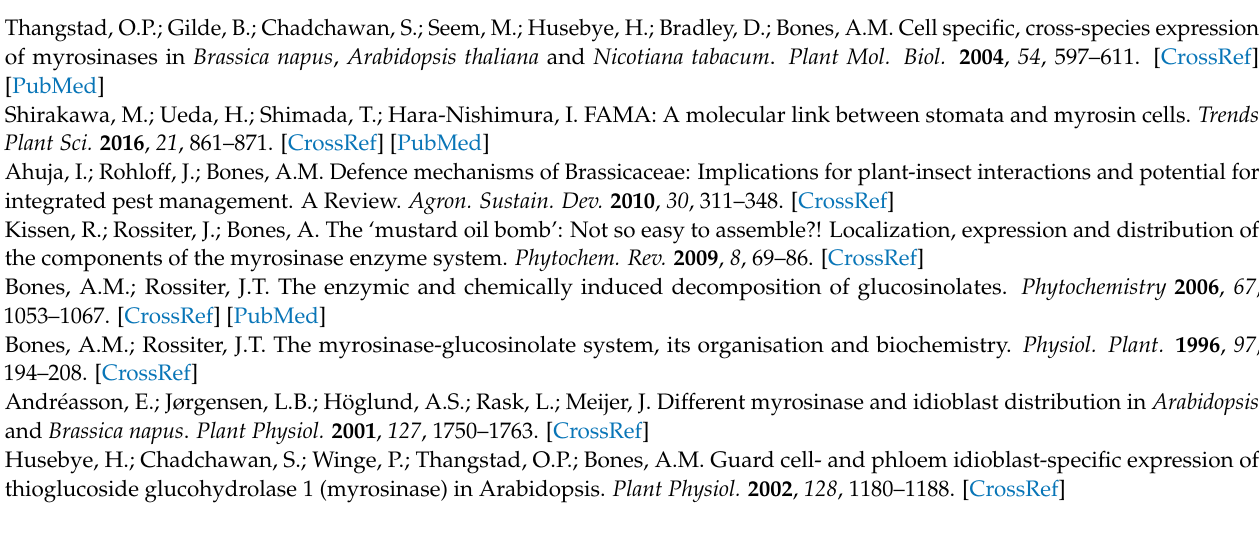
Figure S2: LM of stomata complex and GCs from semi-thin sections (transverse) of rosette leaves of WT, tgg single and double mutants of Arabidopsis stained with toluidine blue. Figure S3: LM visualization of stomata on silicon imprints made from abaxial side of rosette leaves of WT, tgg single and double mutants of Arabidopsis in response to mock treatment. Figure S4: LM visualization of stomata on silicon imprints made from abaxial side of rosette leaves of WT, tgg single and double mutants of Arabidopsis in response to ABA (100 µ M) treatment. Figure S5: LM visualization of stomata on silicon imprints made from abaxial side of rosette leaves from mock and ABA treated (100 µ M) tgg1 tgg2 double mutant of Arabidopsis. Figure S6: TEM of stomata complex and GCs (transdermal sections; abaxial side) from rosette leaves of WT, tgg1 , tgg2 single and tgg1 tgg2 double mutants of Arabidopsis showing variations for outer stomatal ledge. Figure S7: TEM of stomata complex and GCs (transdermal sections) from rosette leaves of tgg2 single and tgg1 tgg2 double mutants of Arabidopsis showing variations for outer stomatal